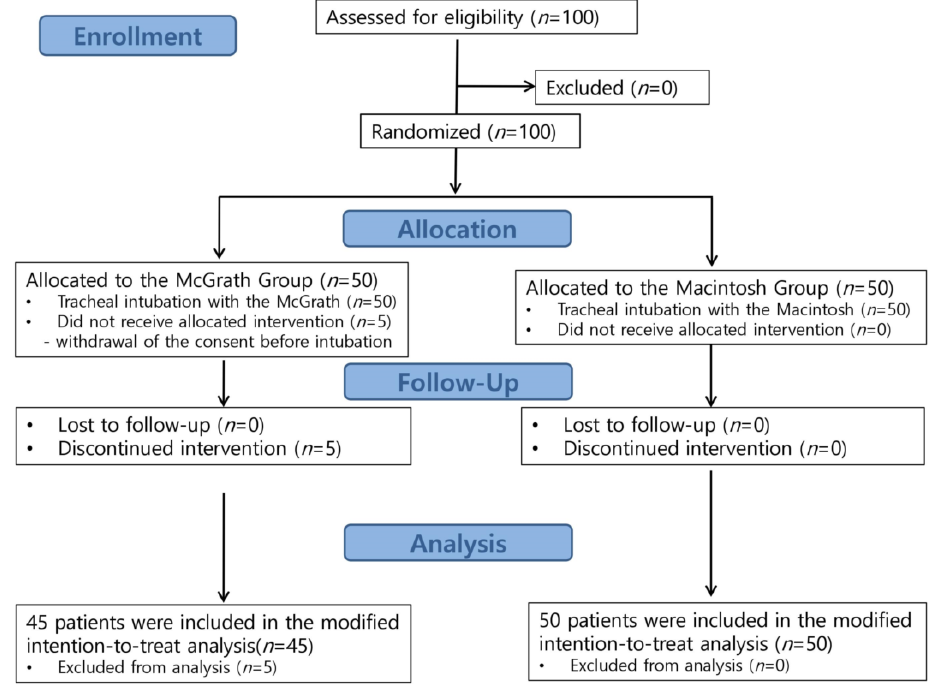
Figure 1. Study flow